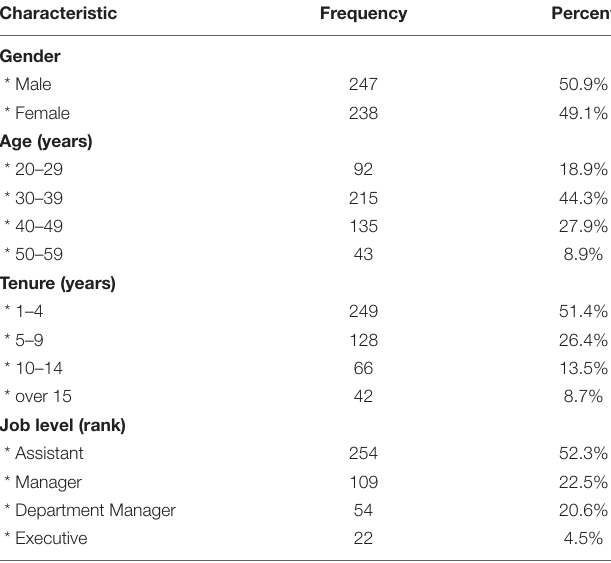
TABLE 1 | Descriptive characteristics of the sample.